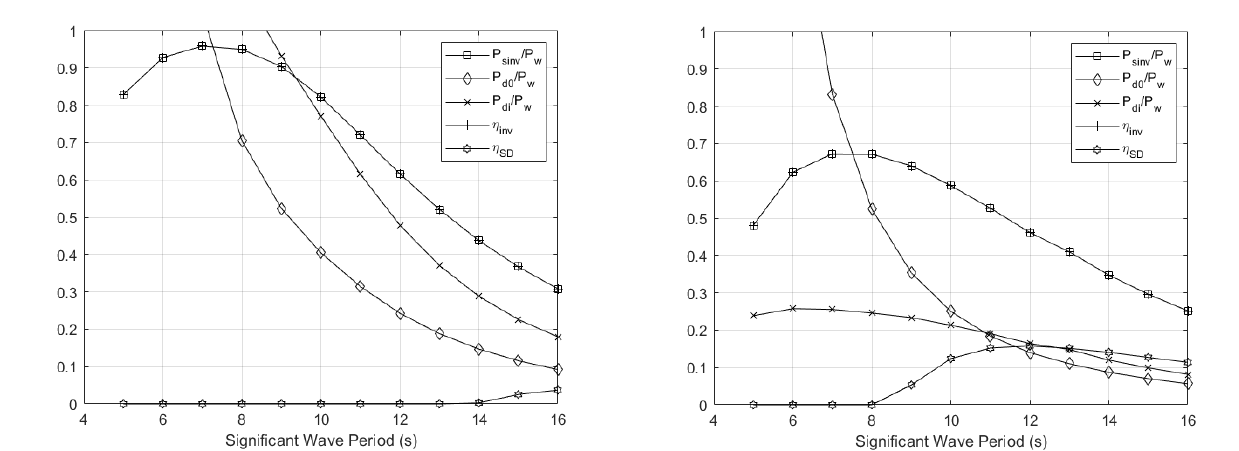
Fig. 13: Cancelled wave power, drag power losses normalized with incoming wave power and inviscid and total efficiency of power conversion for the CycWEC from irregular wave simulations at a significant wave height, Hs = 9s. Left, controller 1. Right, controller